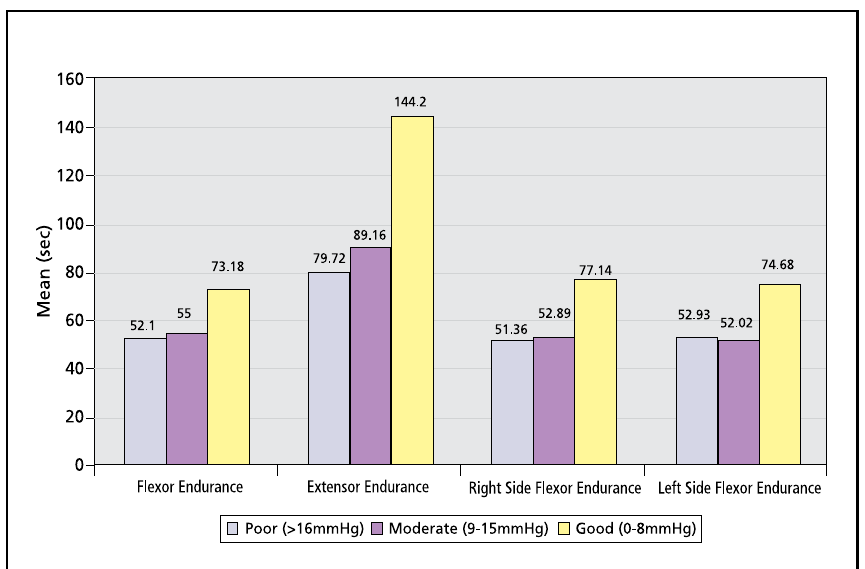
Figure 5: Mean muscle endurance and